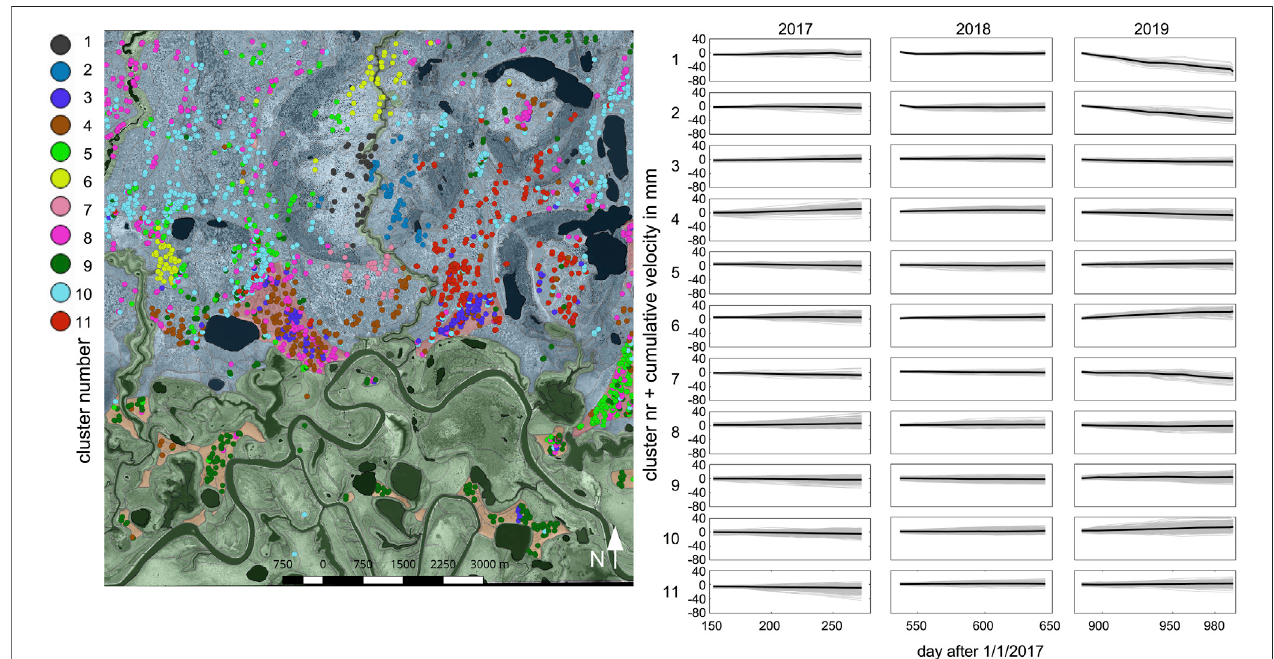
FIGURE11| Left:velocity trajectoryclusterstowhichthe InSARdatapoints were assignedbycluster analysisofsingle InSARimage data (seetext), plottedon the geomorphologicalmapunderlainbyWorldviewimageof2019.Scalebar3 km.Right:Graphsofcumulativevelocitiesplottedagainstimagedateforeachclusterforeach year. Black lines in each graph represent the cluster average velocity over time, grey lines individual point trajectories.